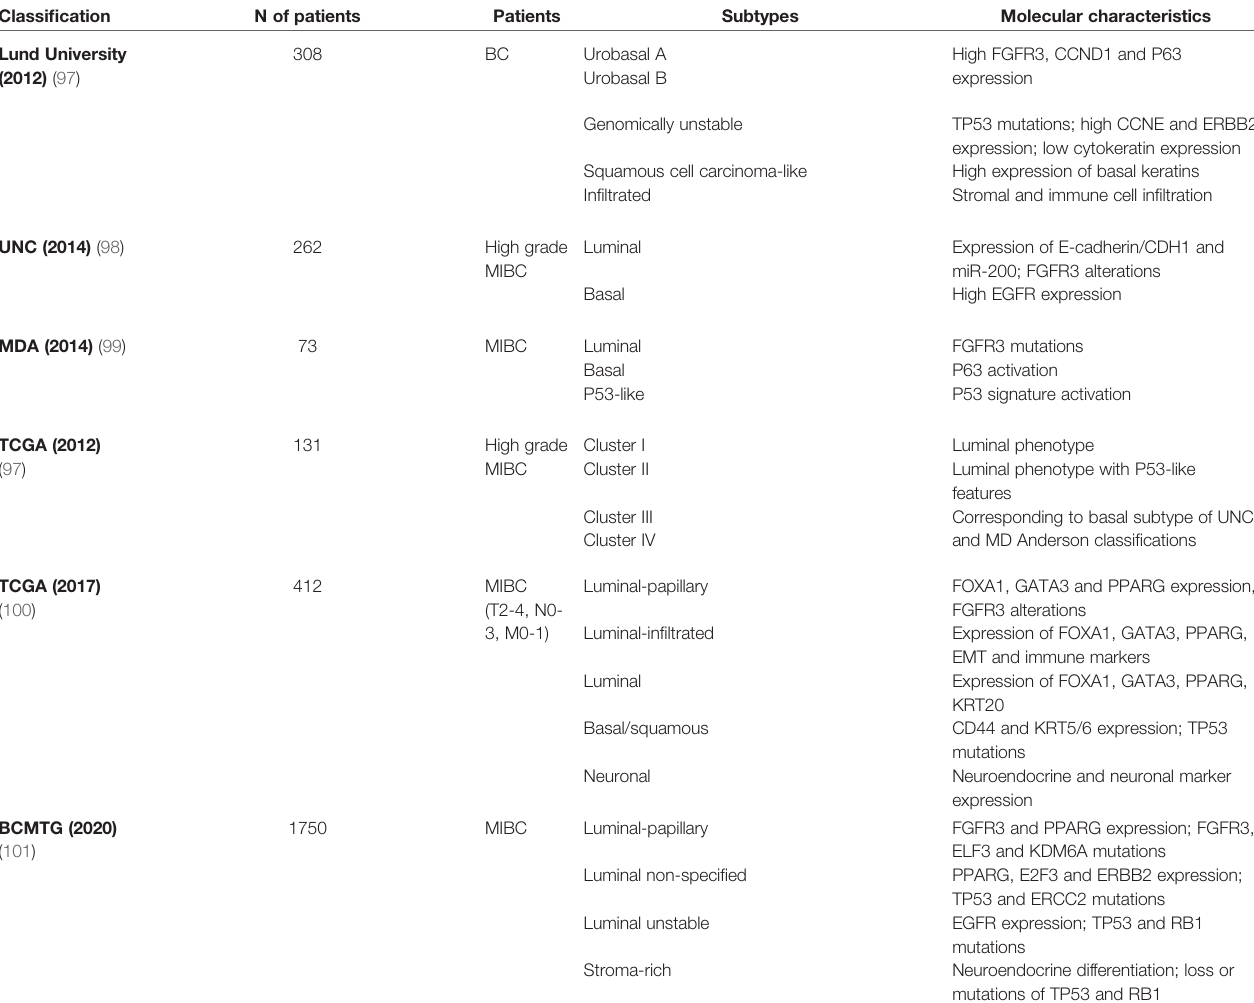
TABLE 5 | Subtypes of bladder carcinoma according to different molecular classi fi